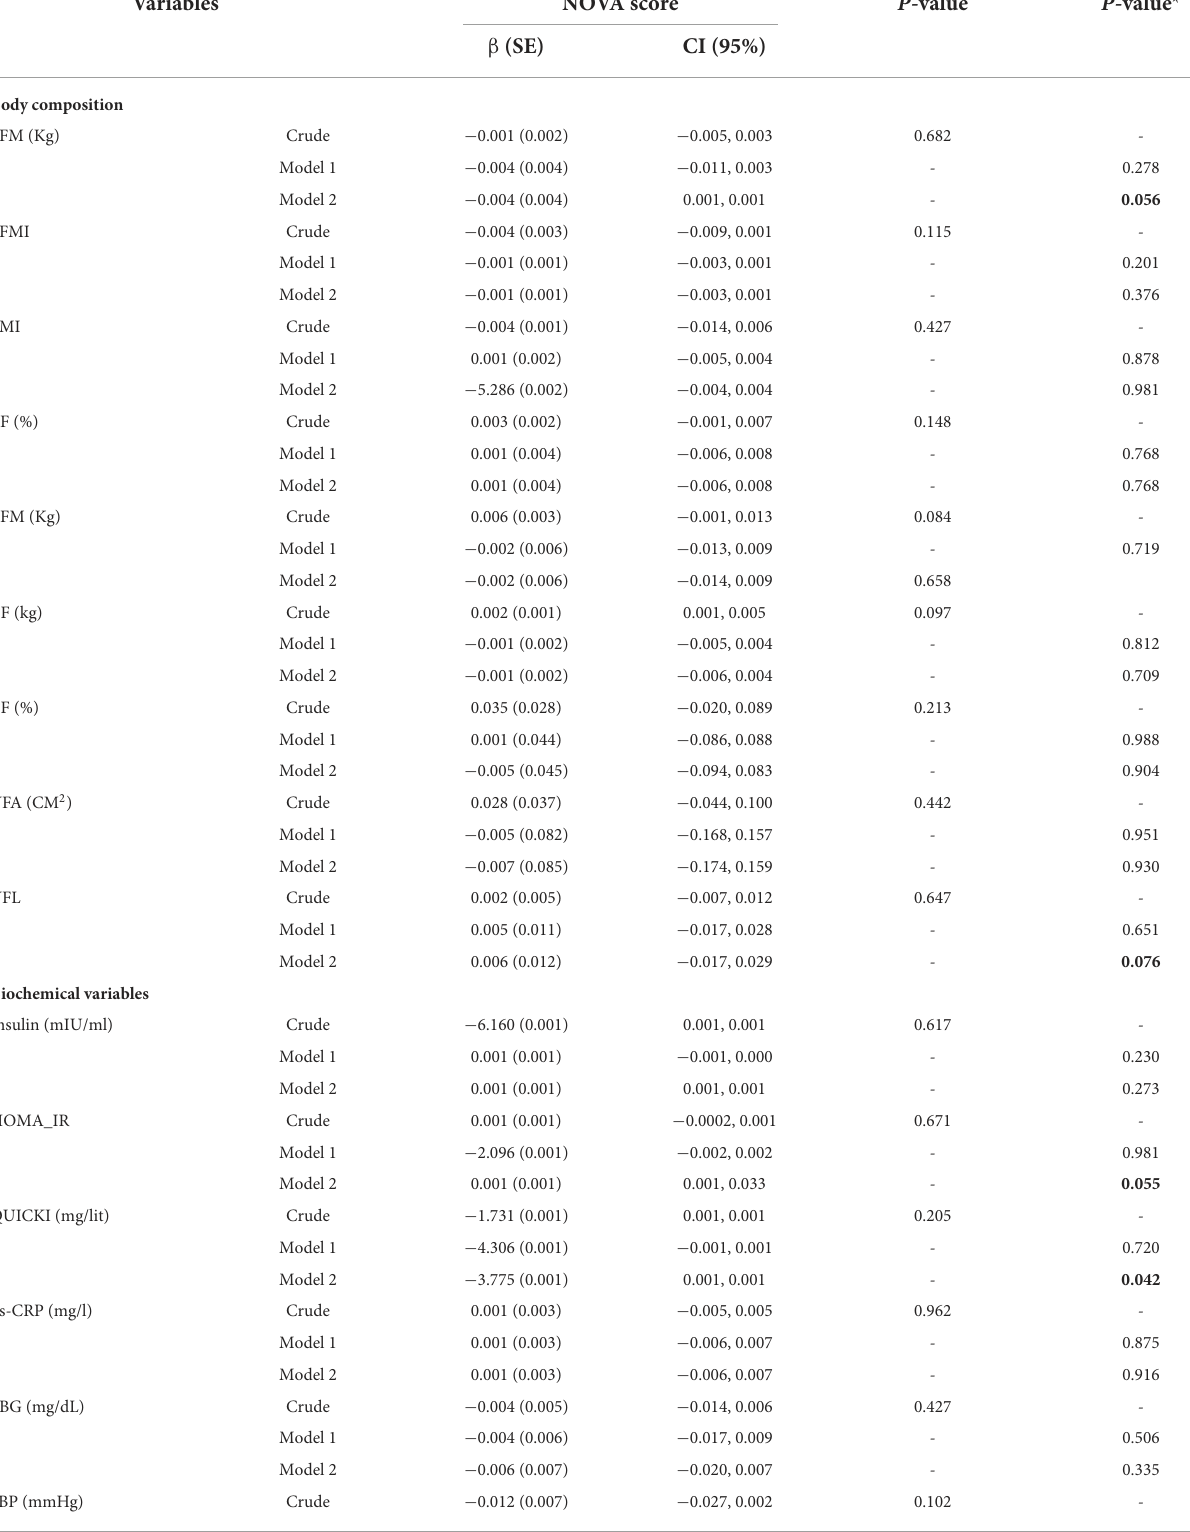
TABLE 4 Association between NOVA score and CVD risk factors, anthropometric measurements, body composition, biochemical variables, and inflammatory factors in obese and overweight women ( n =